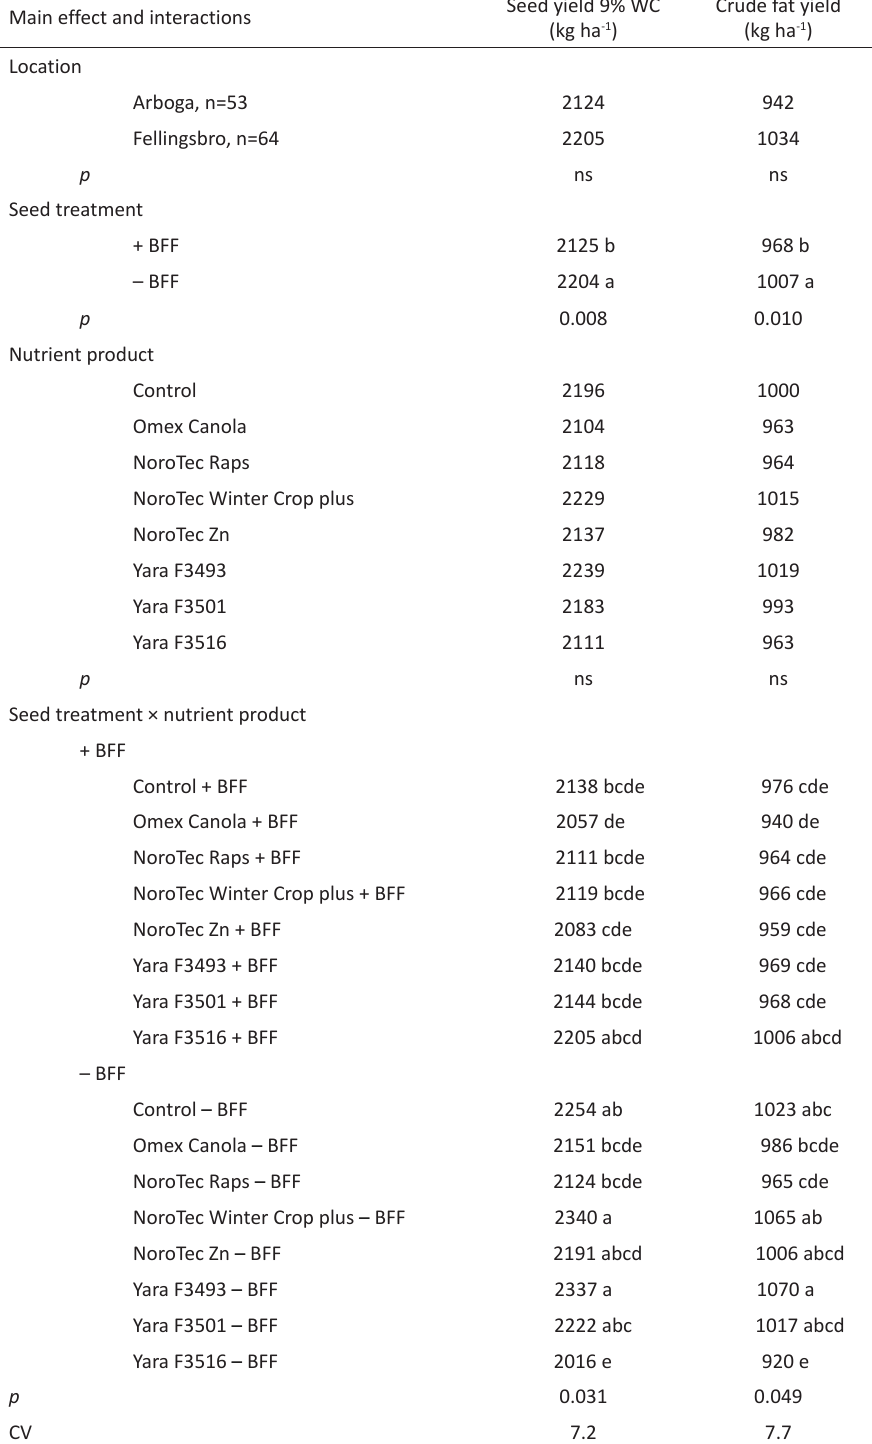
Table 8. Average yield of seed and crude fat in two field experiments 2017 with different seed treatment with (+) and without (–) binder, filler and the fungicide Rovral (BFF) Main effect and